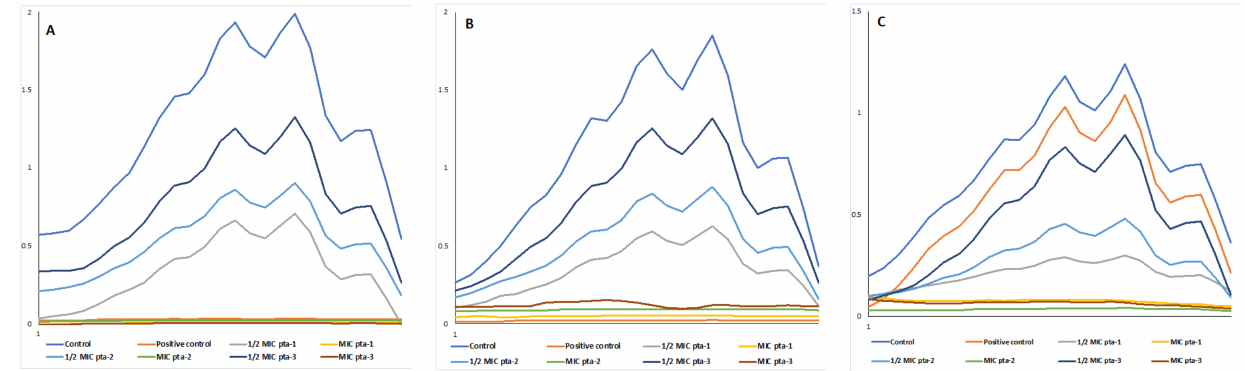
Figure 5. Effect of piperidine based derivatives (pta-1–pta-3) on ergosterol levels in C. albicans SC5314 ( A ), C. albicans 4175 ( B ) and C. albicans 5112 ( C ). Positive controls are represented by the cells treated with 8 µ g/mL of fluconazole while negative controls are represented by healthy